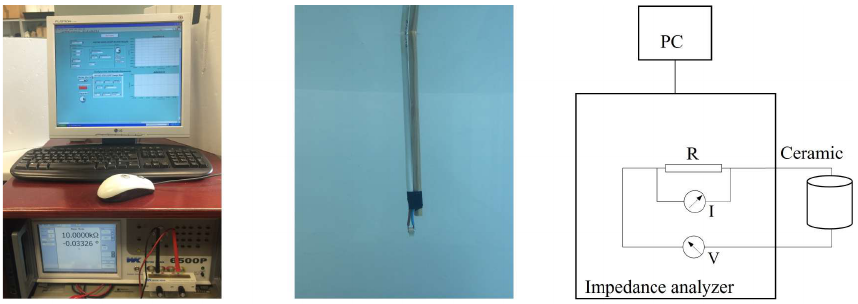
Figure 9. Experimental setup and schematic diagram for impedance measurement.